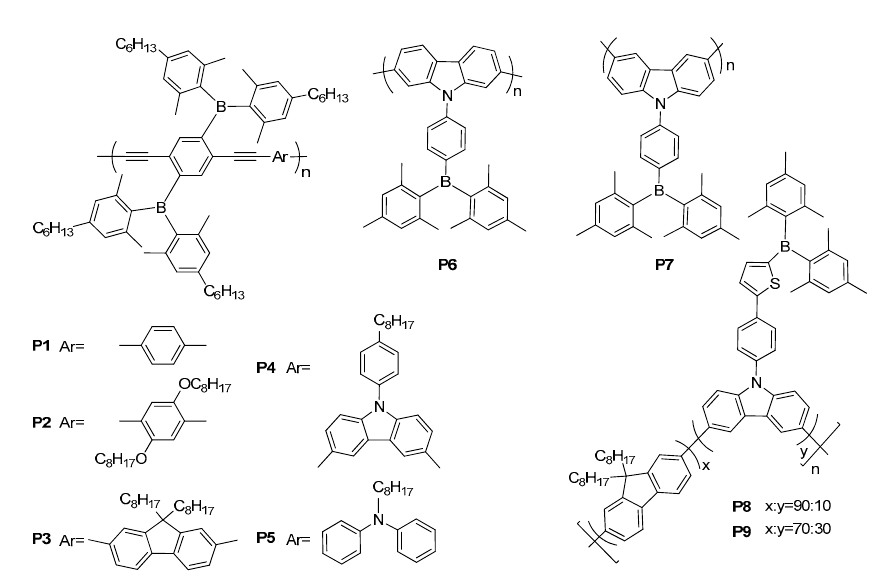
Figure 16. Triarylborane-substituted π -conjugated polymers P1 – P9 .